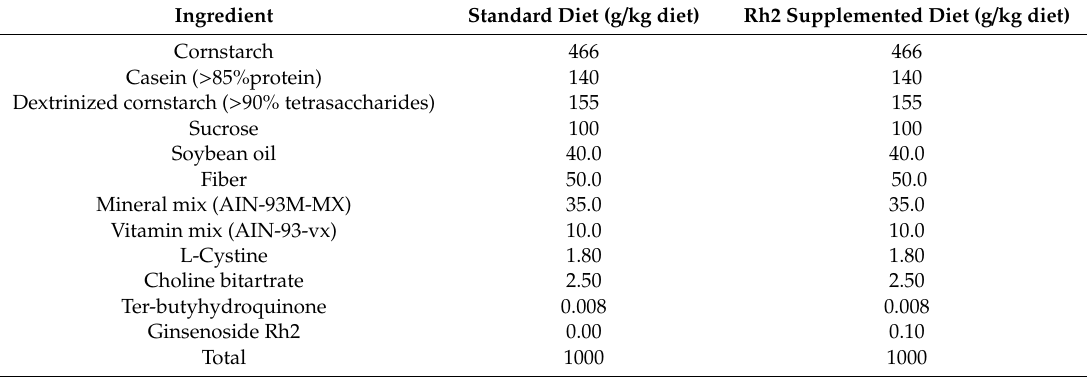
Table 2. Compositions of standard AIN-93G diet and Rh2 supplemented